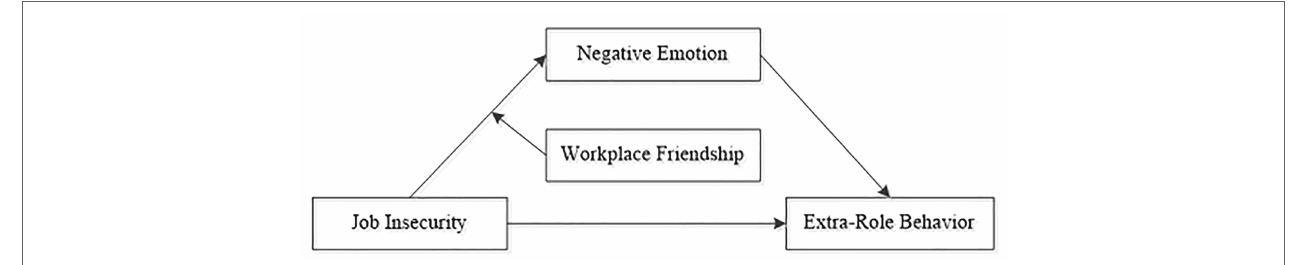
FIGURE 1 | Theoretical framework of the